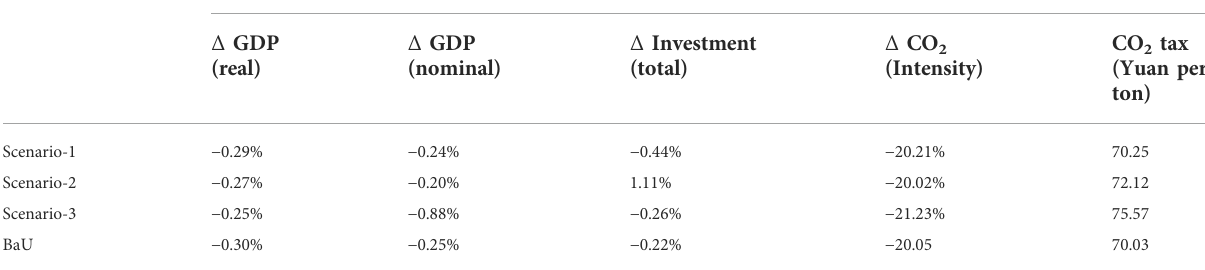
TABLE 8 Carbon emission and economic